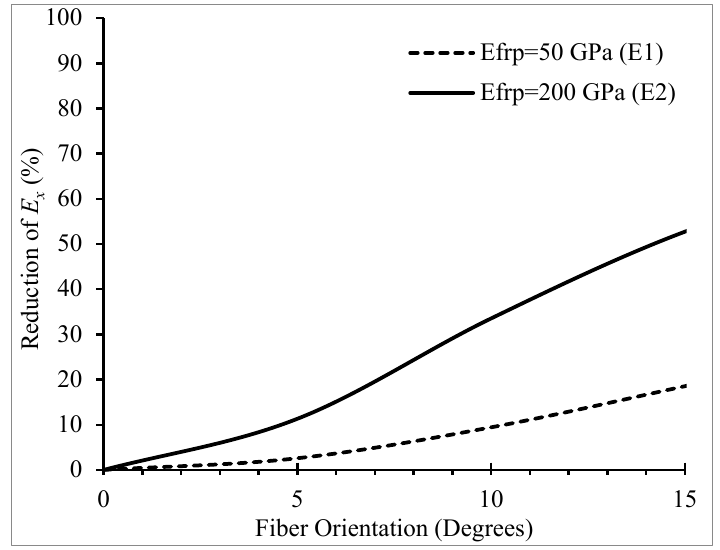
Figure 4. Effect of fiber orientation on FRP hoop modulus of elasticity ( E x ).